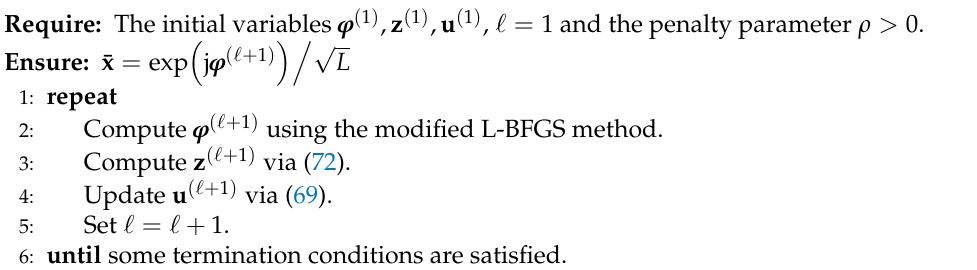
Algorithm 1 Waveform optimization algorithm for the joint